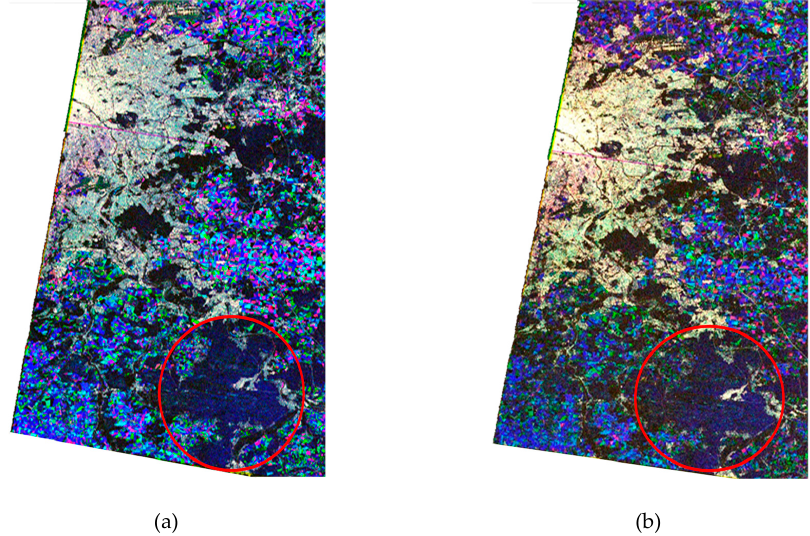
Figure 4. Temporal color-composite | ρ | image, (R: 5–17 May, G: 02–14 Sept., B: 19–31 Dec. 2015).( a ) VV polarization; ( b ) VH polarization. The red circle corresponds to the Fontainebleau Forest.